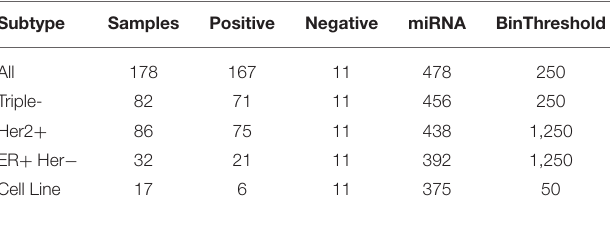
TABLE 1 | Breast cancer dataset description: overall number of samples, number of positive and negative samples, number of miRNAs taken into account and binarization threshold applied for data